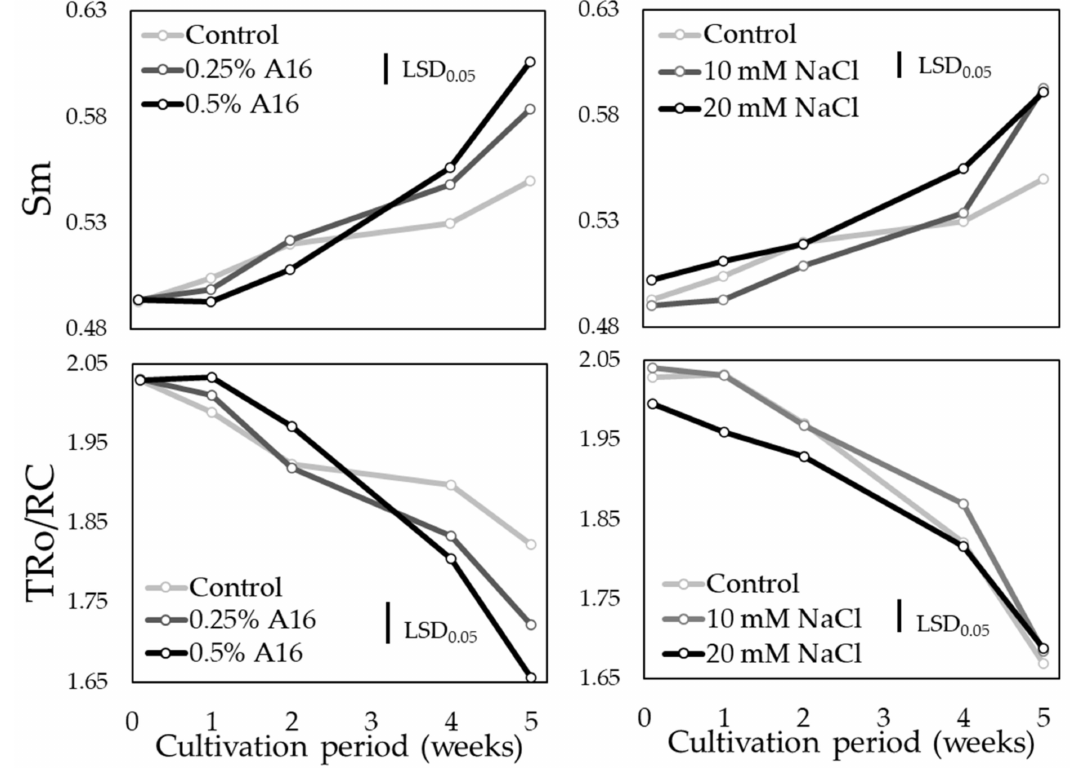
Figure 4. Chlorophyll fluorescence parameters (Sm and TRo/RC) of peppermint plants grown hydroponically in a floating system on a nutrient solution supplemented either with 0, 0.25, or 0.50% of a commercial amino acid solution (Amino16 ® ) or 0, 10, and 20 mM NaCl. Each column is the mean of three replications with 16 plants per replication. The vertical lines depict the least significant differences values (LSD) at p <